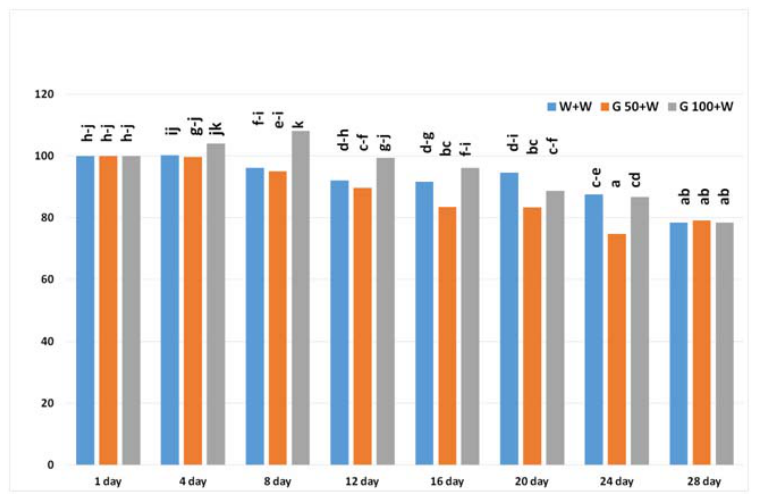
Figure 1. Effect of postharvest treatment on the SPAD chlorophyll content index change of Viola odorata leaves (%).